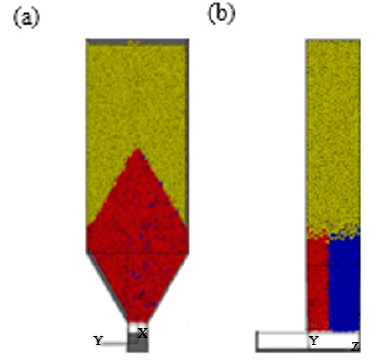
Figure 8. Single model design.